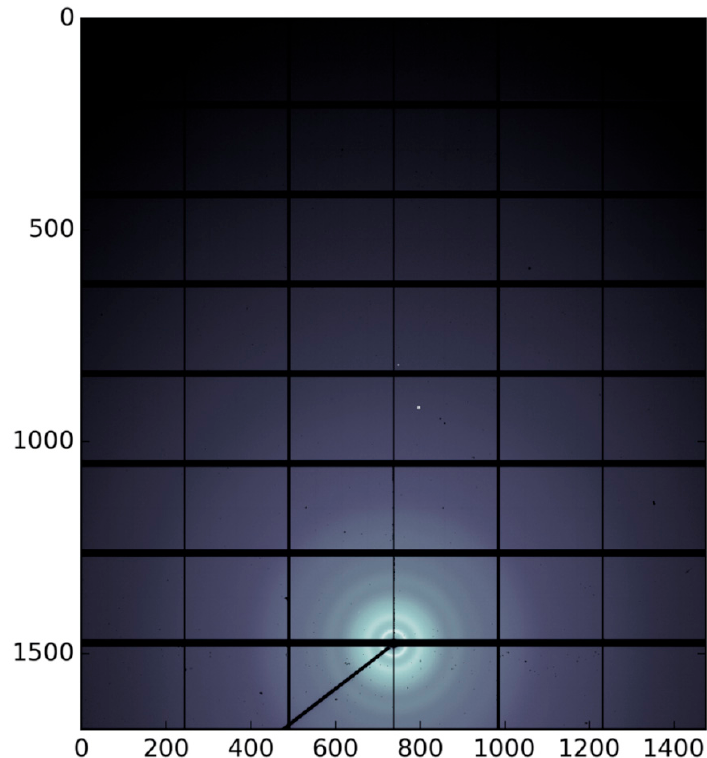
Figure A4. Raw two-dimensional images of PEDOT_SPAES_0.5.